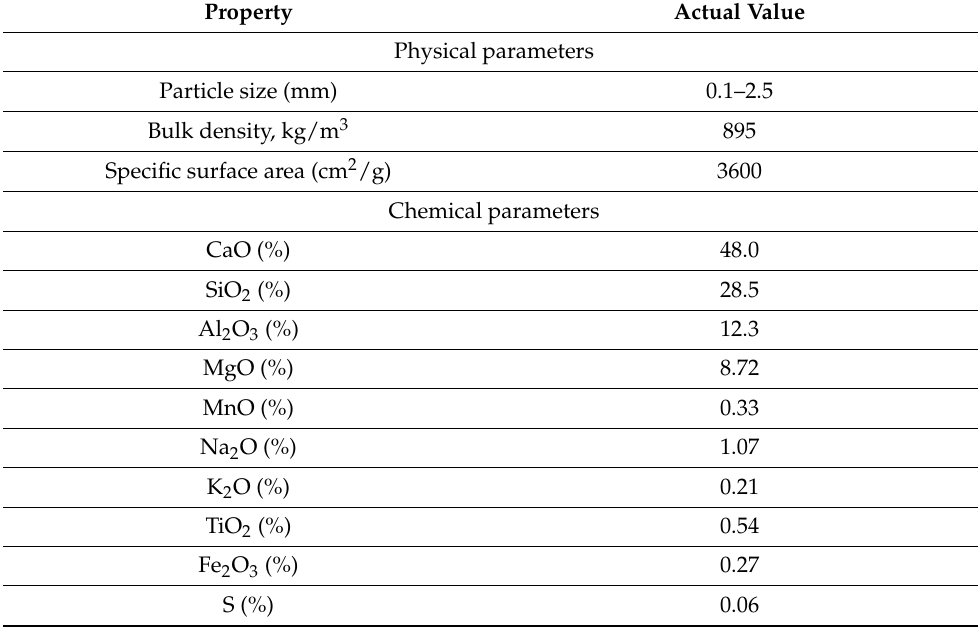
Table 3. Characteristics of GGBS.